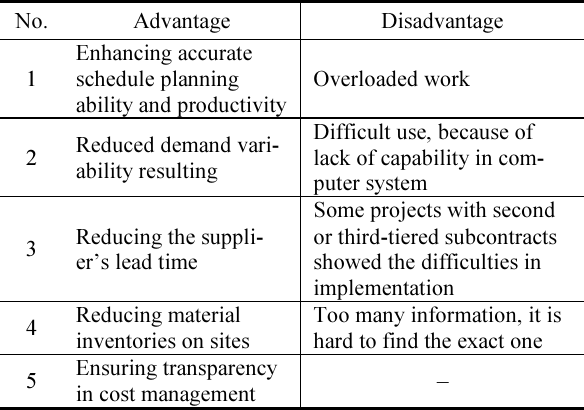
Table 5. Advantages and disadvantages of using the